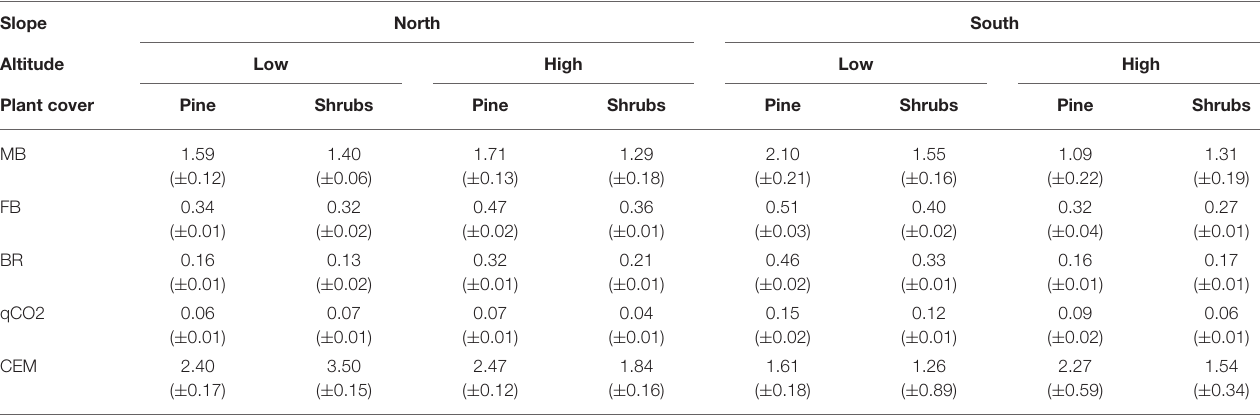
TABLE 2 | Mean values ( ± s.e.) of microbial biomass (MB, expressed as mg C g − 1 d.w.), fungal biomass (FB, expressed as mg g − 1 d.w.), basal respiration (BR, expressed as mg